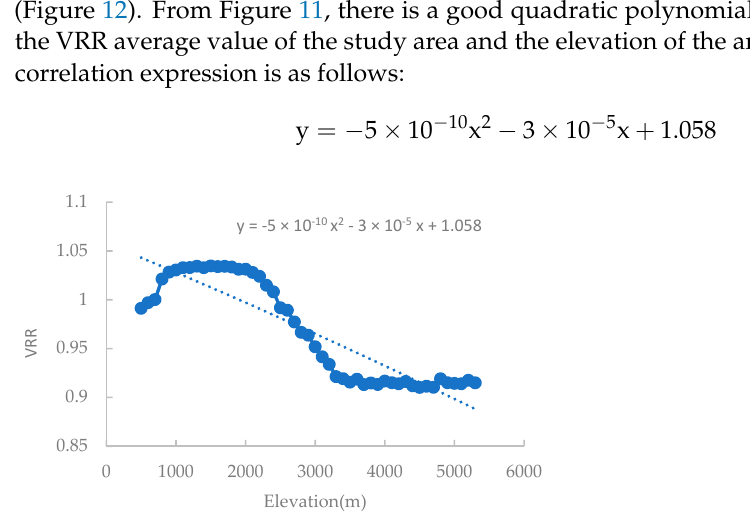
Figure 12. Correlation analysis between VRR and elevation.